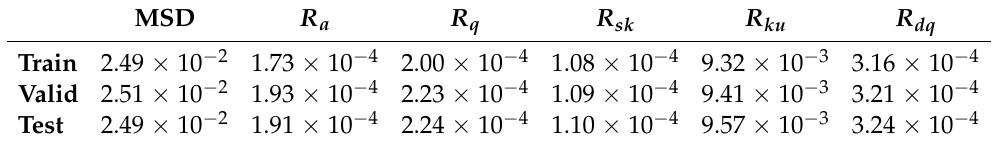
Table 7. Mean difference on test set with MAE.